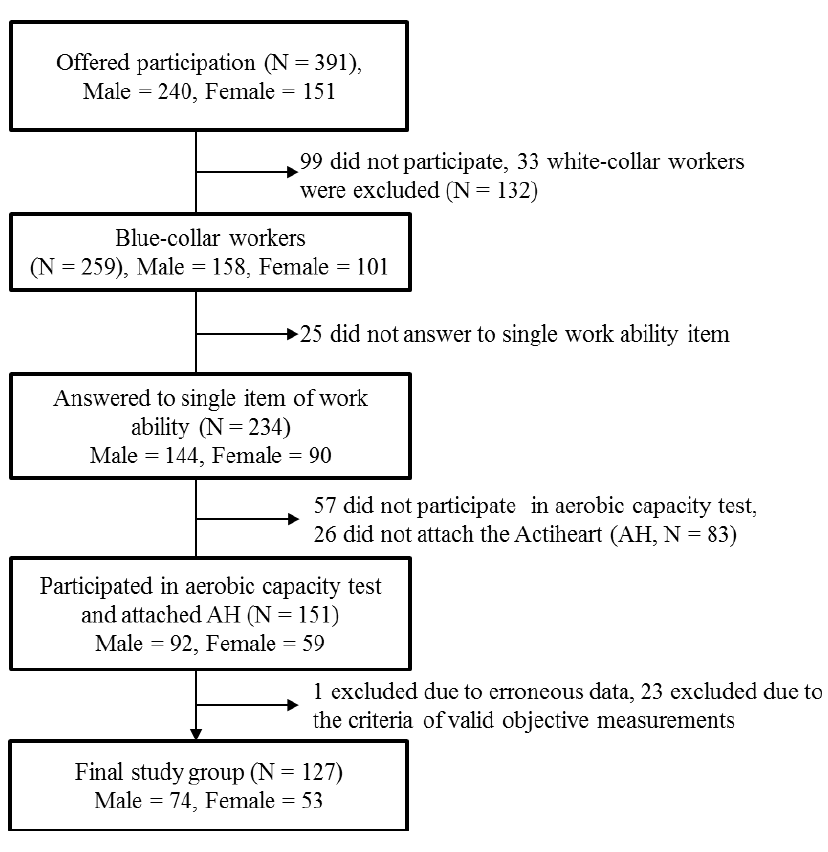
Table 1. Demographic characteristics of the male and female workers based on the single item self-reported work ability